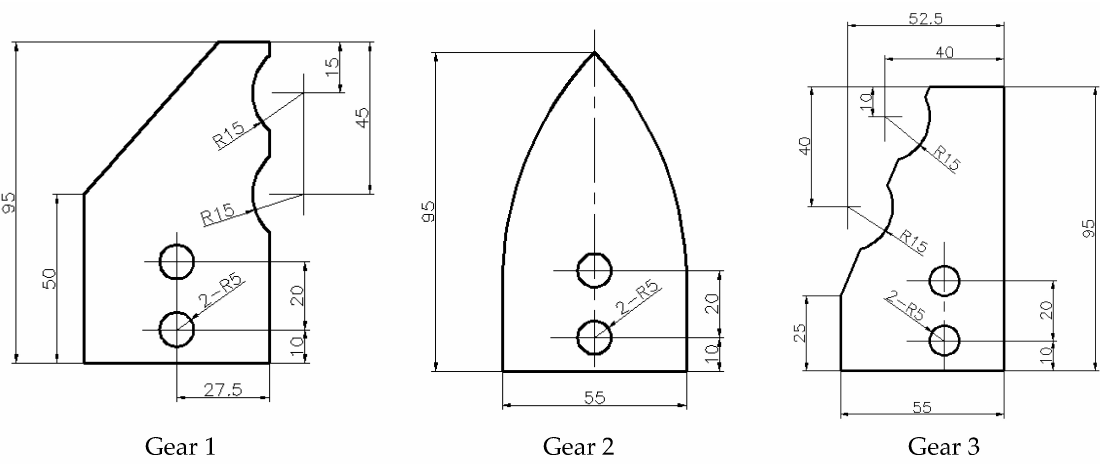
Figure 13. Gear Profile.